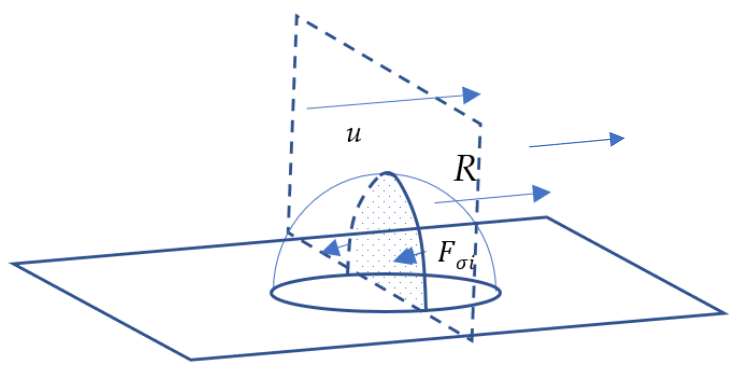
Figure 5. Sketch of the droplet stability Figure 5. S ketch of the droplet stability balance.